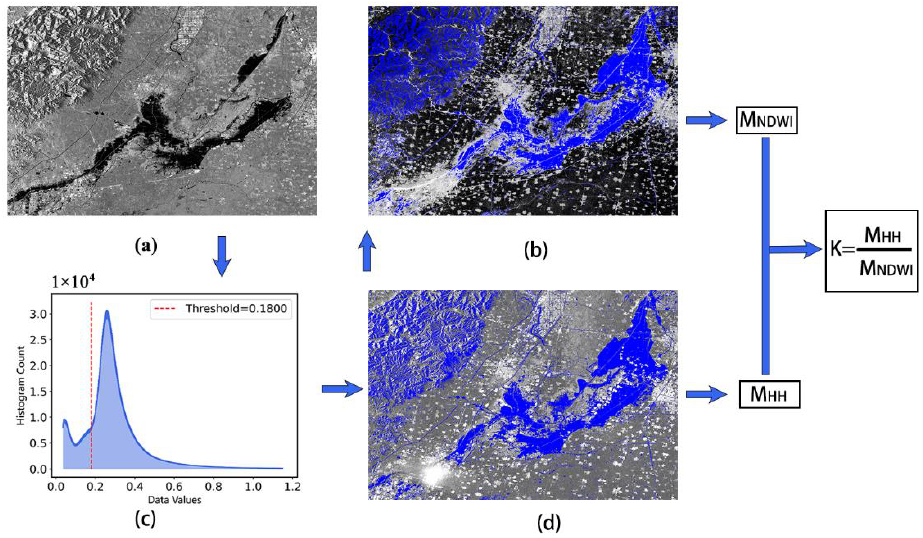
Figure 3. Example of the calculation of the balance coefficient K: ( a ) SAR imagery. ( b ) Regions with small backscattering coefficients in the NDWI (blue area). ( c ) HH histogram (red line represents the threshold). ( d ) Regions with small backscattering coefficients in SAR imagery (blue area).